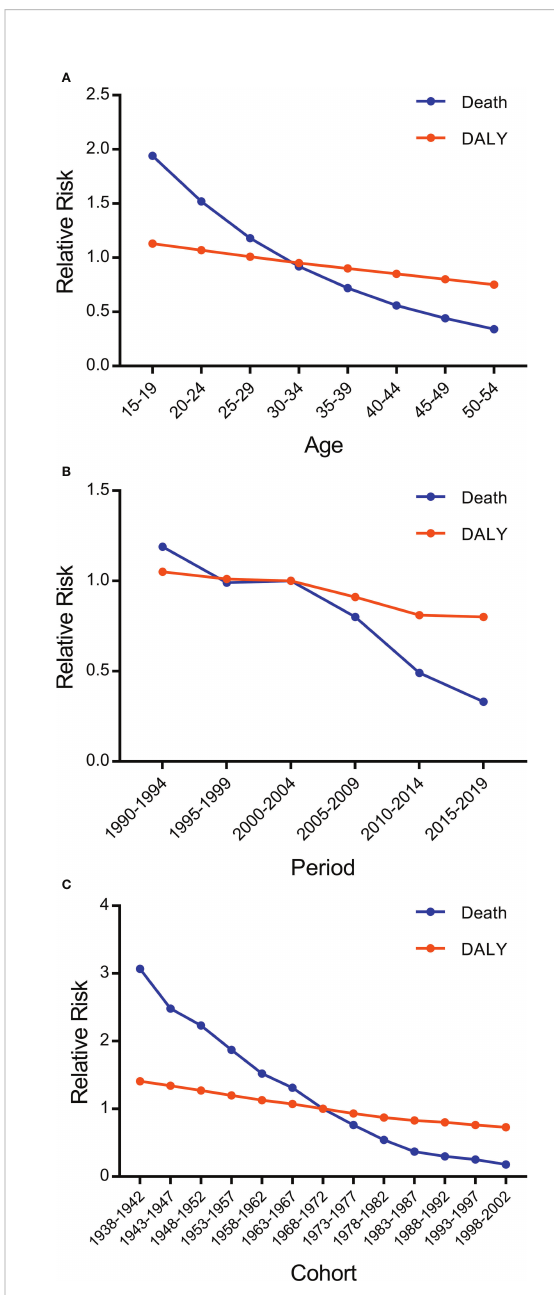
FIGURE 1 Death and disability-adjusted life years (DALY) relative risks of endometriosis due to (A) age, (B) period, and (C) cohort effects.